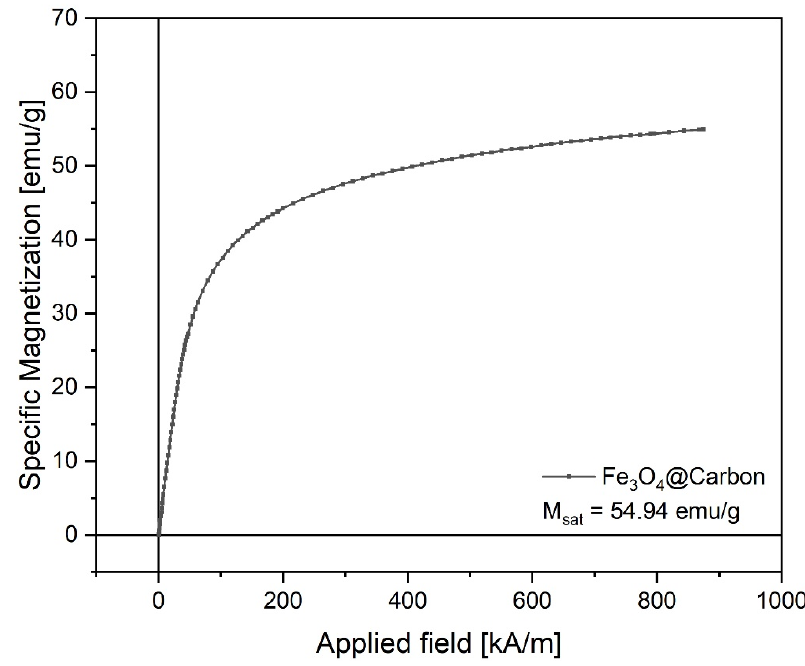
Figure 5. Magnetization curve of Fe 3 O 4 @Carbon nanoparticles.